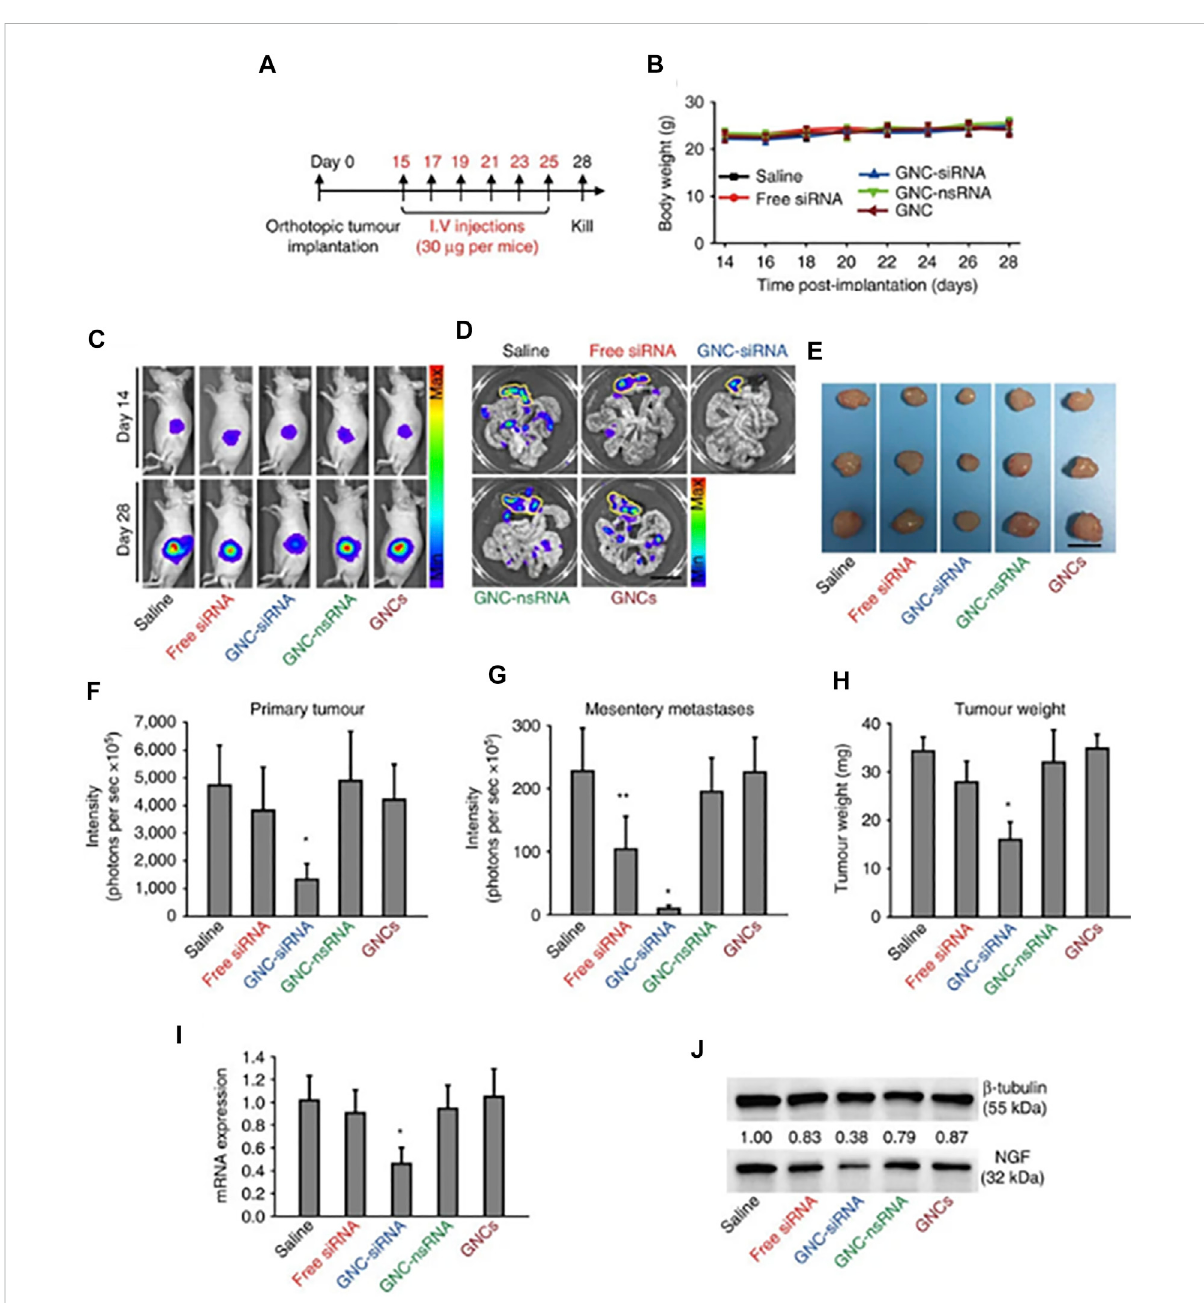
FIGURE 5 (A) Scheme of siRNA treatment. Panc-1-luc cells were injected into the pancreas head of Balb/c nude mice to form orthotopic tumors. After 2 weeks,miceweredividedintodifferentgroups.Micereceivedvariousformulationsviatail-veilinjections,sixtimes,andwereeuthanizedonday28. (B) Changes in mouse body weight during treatments. (C) In vivo whole-body bioluminescence images of mice on day 14 and day 28, which indicatedthetumorsizebeforeandaftersiRNAtreatment.BioluminescencesignalsresultedfromtheinteractionofluciferasefromPanc-1-luc cells with D-luciferin injected into the mice before imaging. (D) Ex vivo bioluminescence images of orthotopic pancreatic tumors and tumor metastases into mesenteries on day 28. Yellow lines indicate the locations of primary tumors in the pancreas. Scale bar, 1 cm. (E) Tumor images on day 28. Scale bar, 5 mm. (F) Quanti fi cation of in vivo bioluminescence to evaluate the primary tumors in mice on day 28. (G) Quanti fi cation of tumor metastases by the sum of ex vivo bioluminescence detected in the mesenteries on day 28. (H) Weight of the isolated tumors. (I) NGF mRNA and (J) NGF protein expression levels in orthotopic tumors. Reproduced with permission (Lei et al., 2017). Copyright 2017, Springer